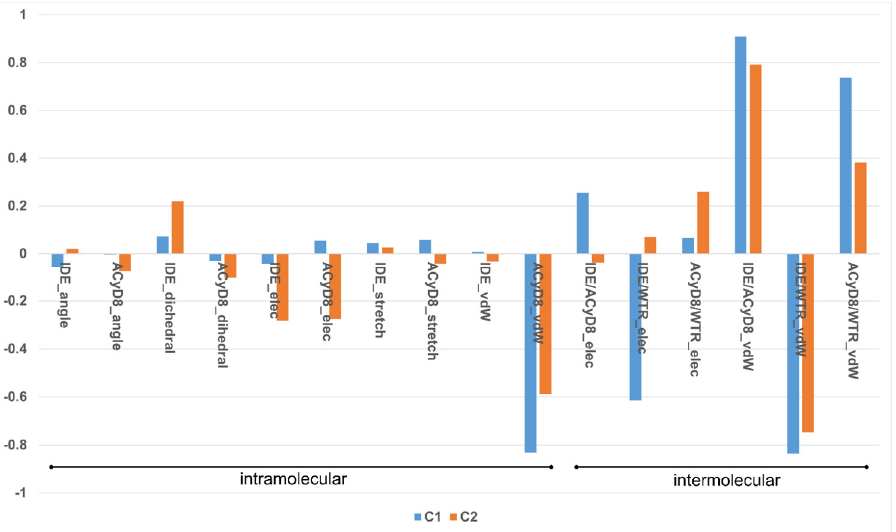
Figure 8. Plot of the correlation coefficients between IDE RMSD and force-field energy terms.